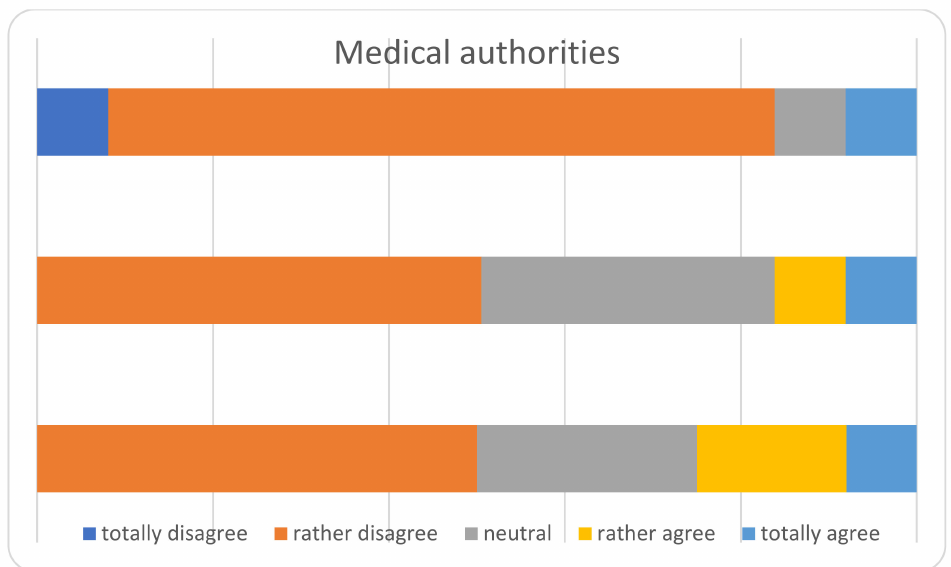
Figure 3. Perceived role of the medical